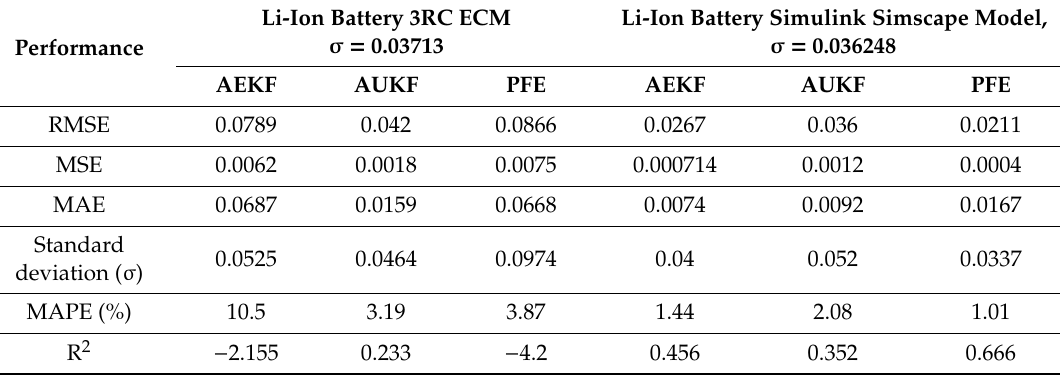
Table A4. Statistical errors—SOC estimates versus Li-ion battery Simscape model SOC values—Scenario R4: (SOCini = 0.2, temperature e ff ects on Rin and